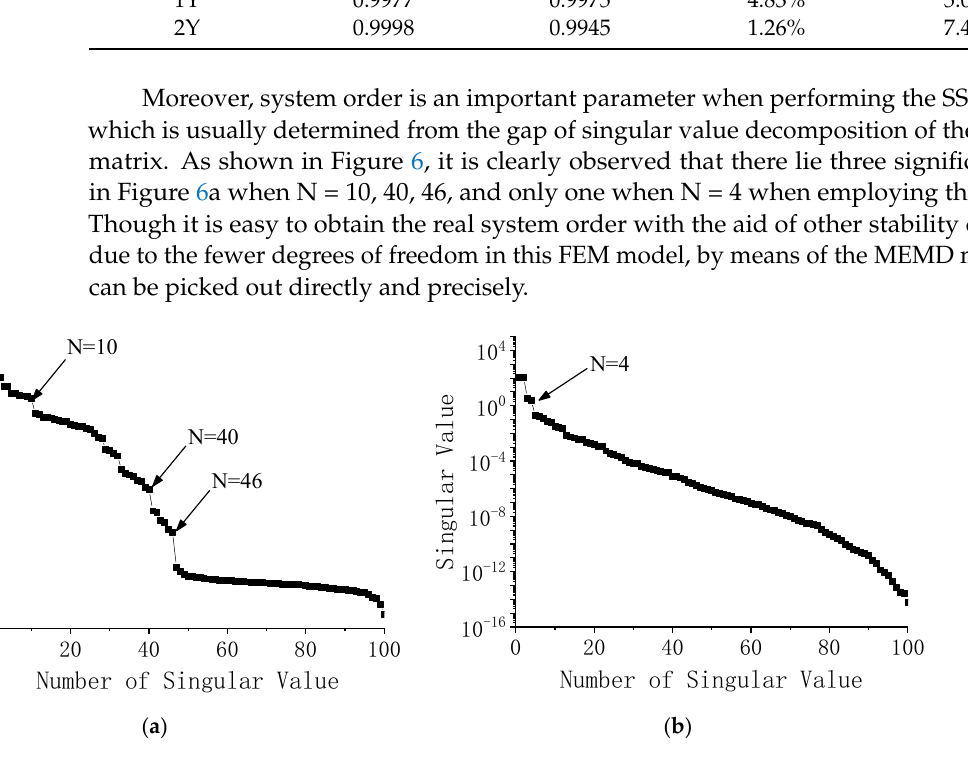
Figure 6. Singular spectrum from SVD of Toeplitz matrix. ( a ) Original data; ( b ) IMFs decomposed by MEMD.